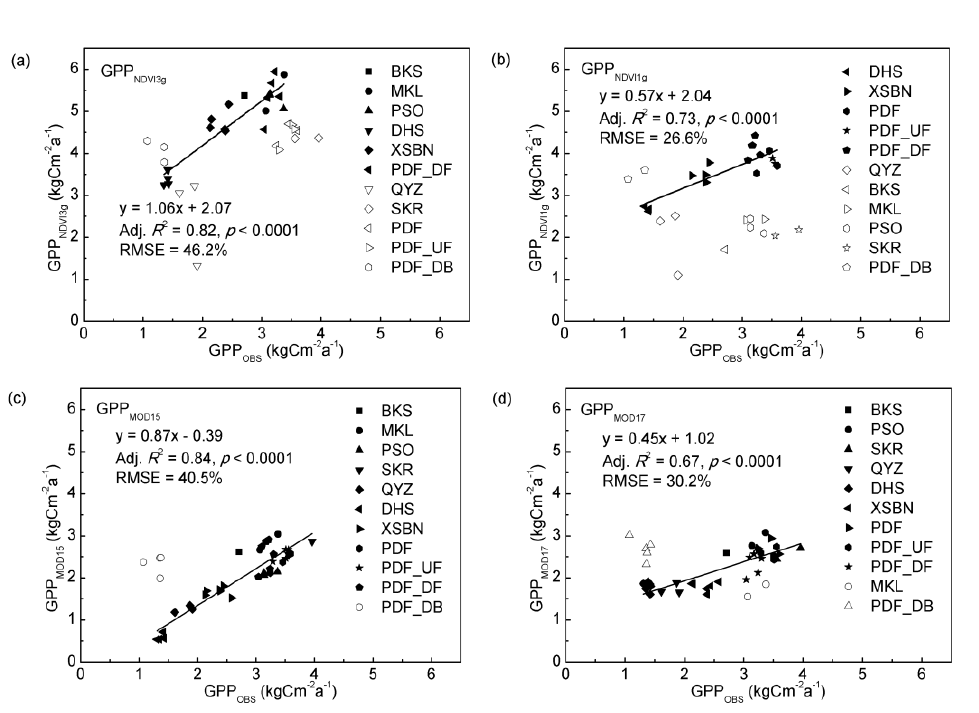
Figure 5. GPP data published in peer-reviewed literature (Table 1) compared with GPP modeled with the FPAR from GIMMS NDVI3g (GPP , ( a )), GIMMS NDVI NDVI3g (GPP , ( b )), MOD15A2 (GPP , ( c )) through GLOPEM-CEVSA model, and NDVI1g MOD15